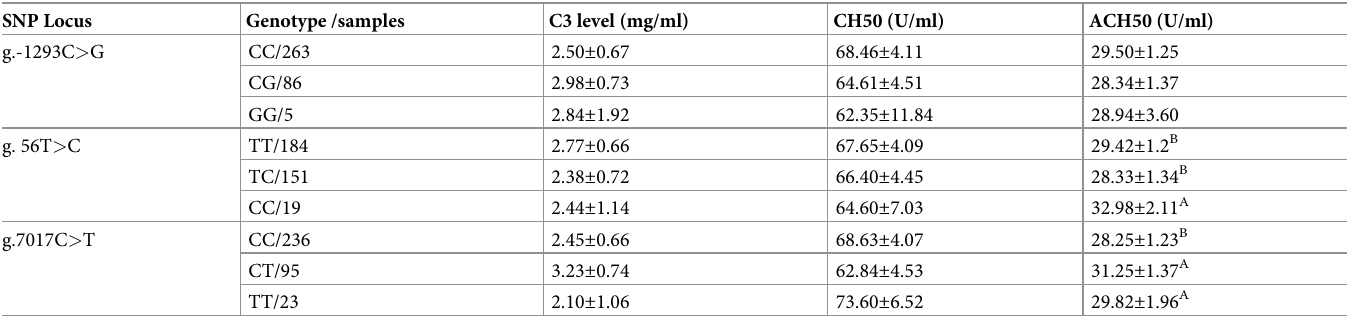
Table 7. Least squares mean (LSM) ± standard errors (SE) of various milk production traits in relation to different C3 genotypes among 354 Chinese Holstein cows. SNP